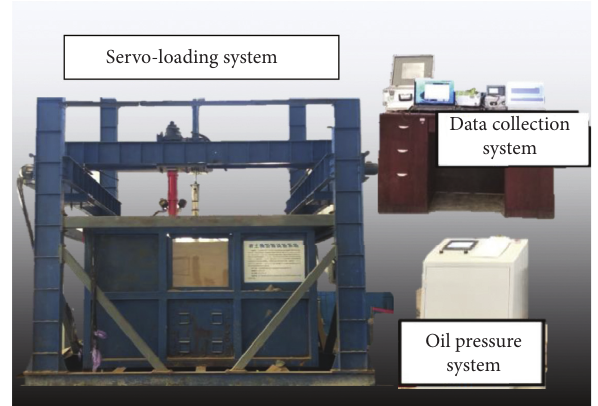
Figure 1: The large-scale model casing test